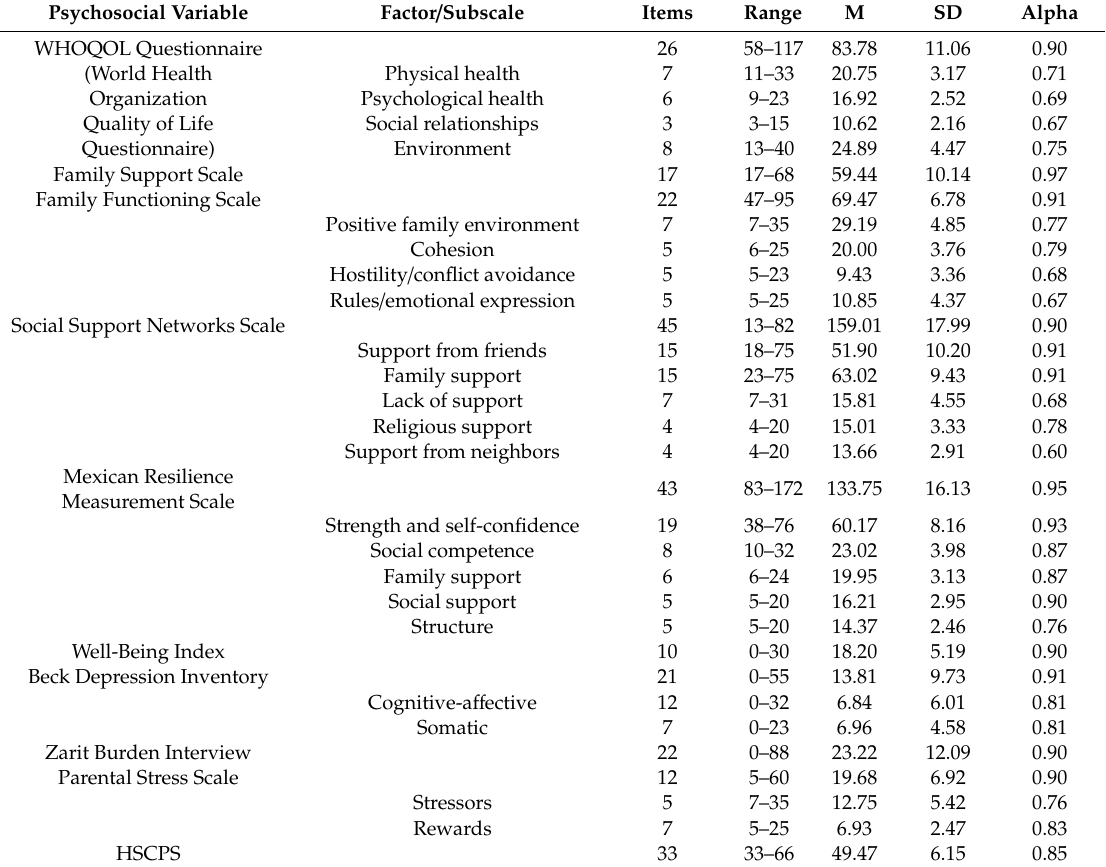
Table 2. Descriptive factors / subscales and psychosocial